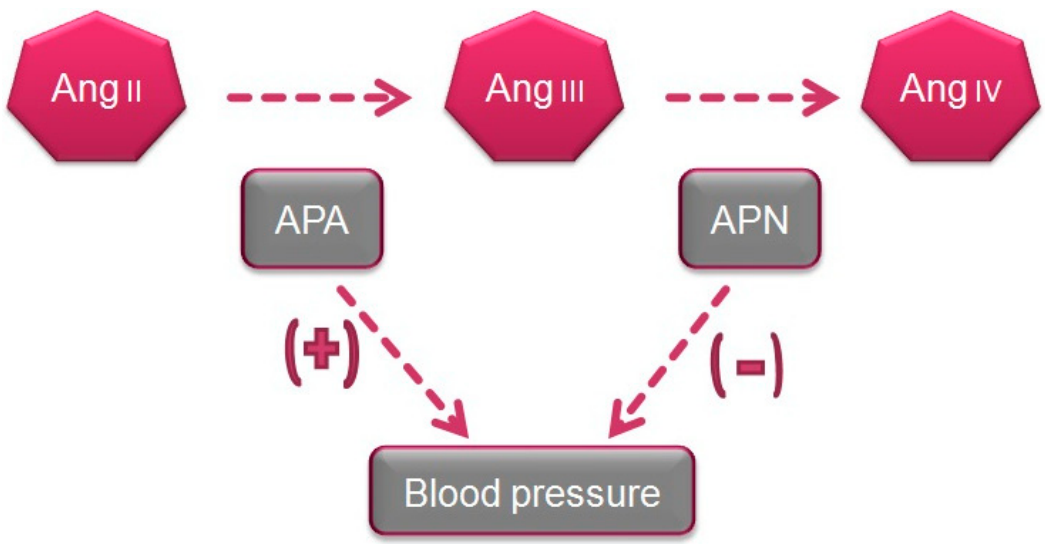
Figure 3. Systemic and renal APA and APN in the control of blood pressure and renal function .